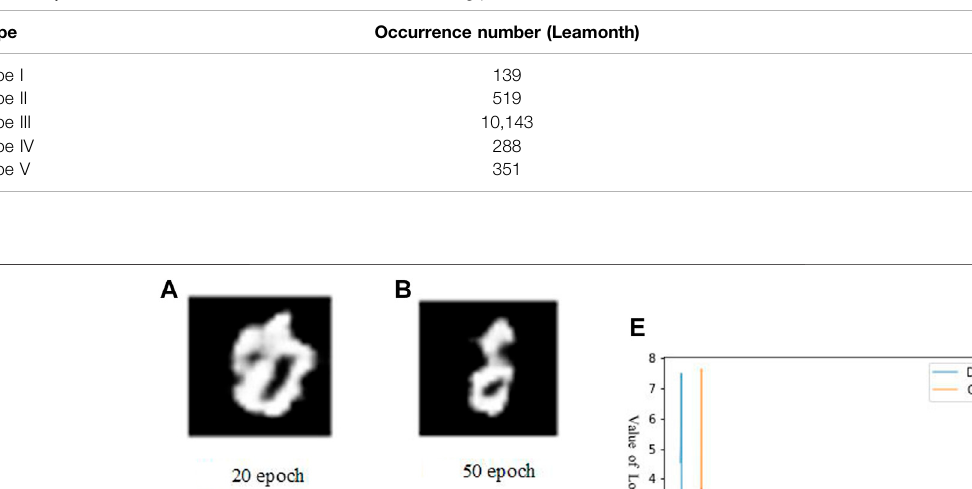
TABLE 1 | Event number of solar radio bursts used in the training process from the two stations.